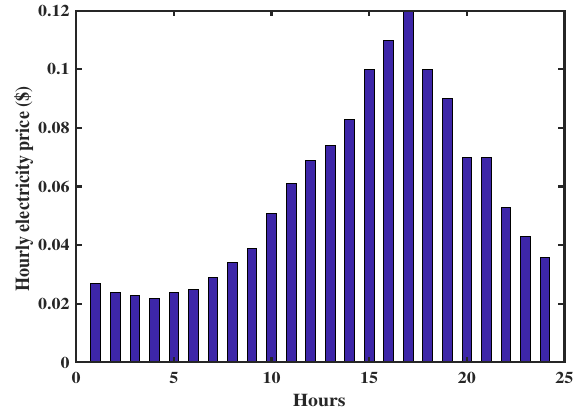
Figure 9. Day-ahead electricity price.